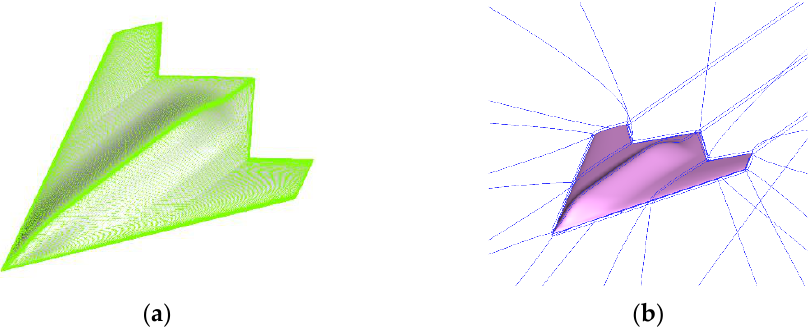
Figure 2. Computational grid topology. ( a ) Surface grid; ( b ) grid blocks.